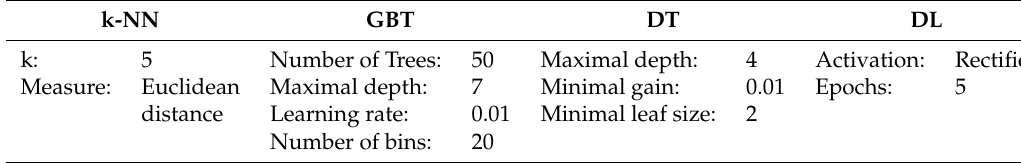
Table 5. Machine learning algorithms parameters